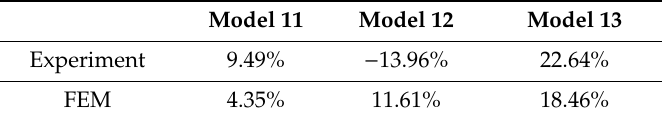
Table 8. Results